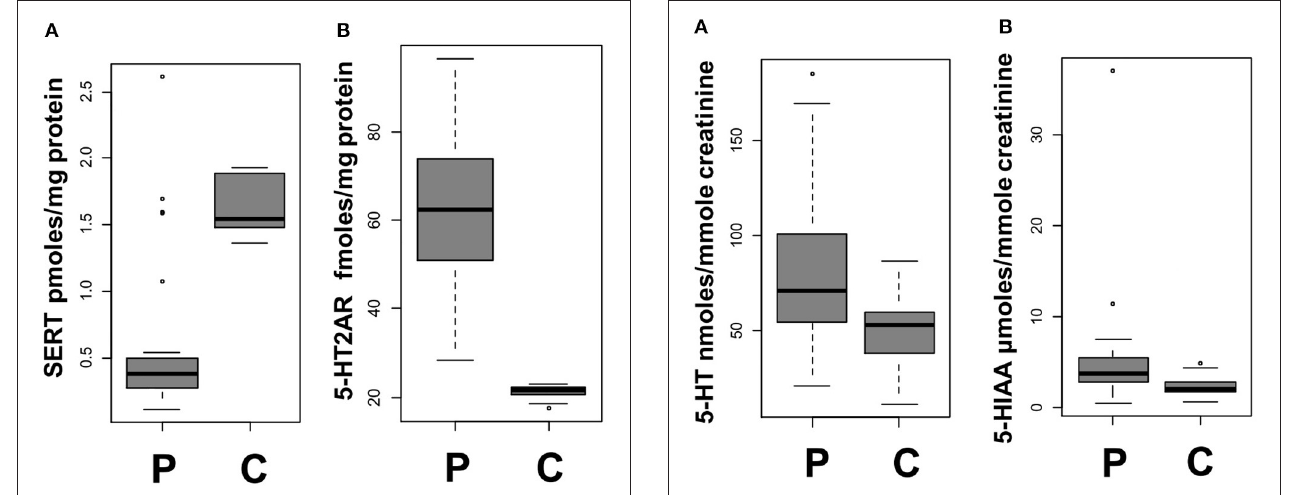
FIGURE 1 | Platelet markers at day 0. (A) Blood platelet 5-HT transporter (SERT) density in patients (P) and controls (C) ( p = 10 − 5 ). (B) Blood platelet 5-HT receptor (5-HT2AR) density in patients (P) and controls (C) ( p < 10 − 6 ). Each gray square indicates the interquartile range (IQR) and the black line the median.